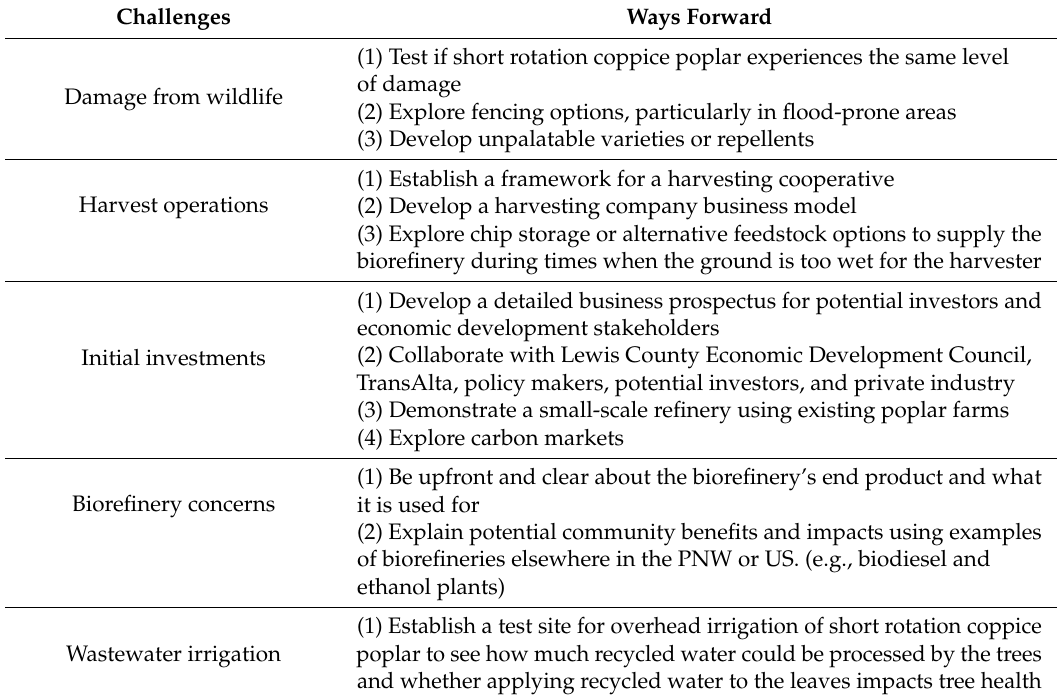
Table 6. Strategies for addressing challenges to developing a poplar-based bioeconomy in southwestern WA,